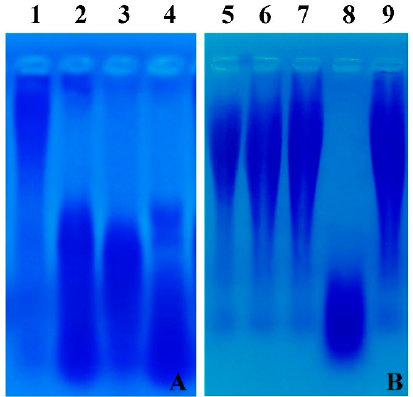
Figure 7. ( A ) Degradation of γ -PGA in Cheonggukjang samples. Extracted γ -PGA was